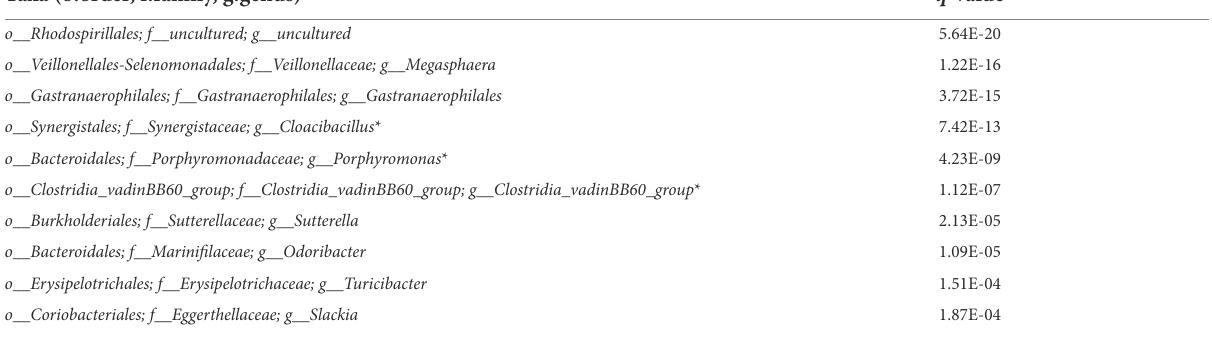
TABLE 4 Top 10 microbiome genera ranked by Cauchy combination test.